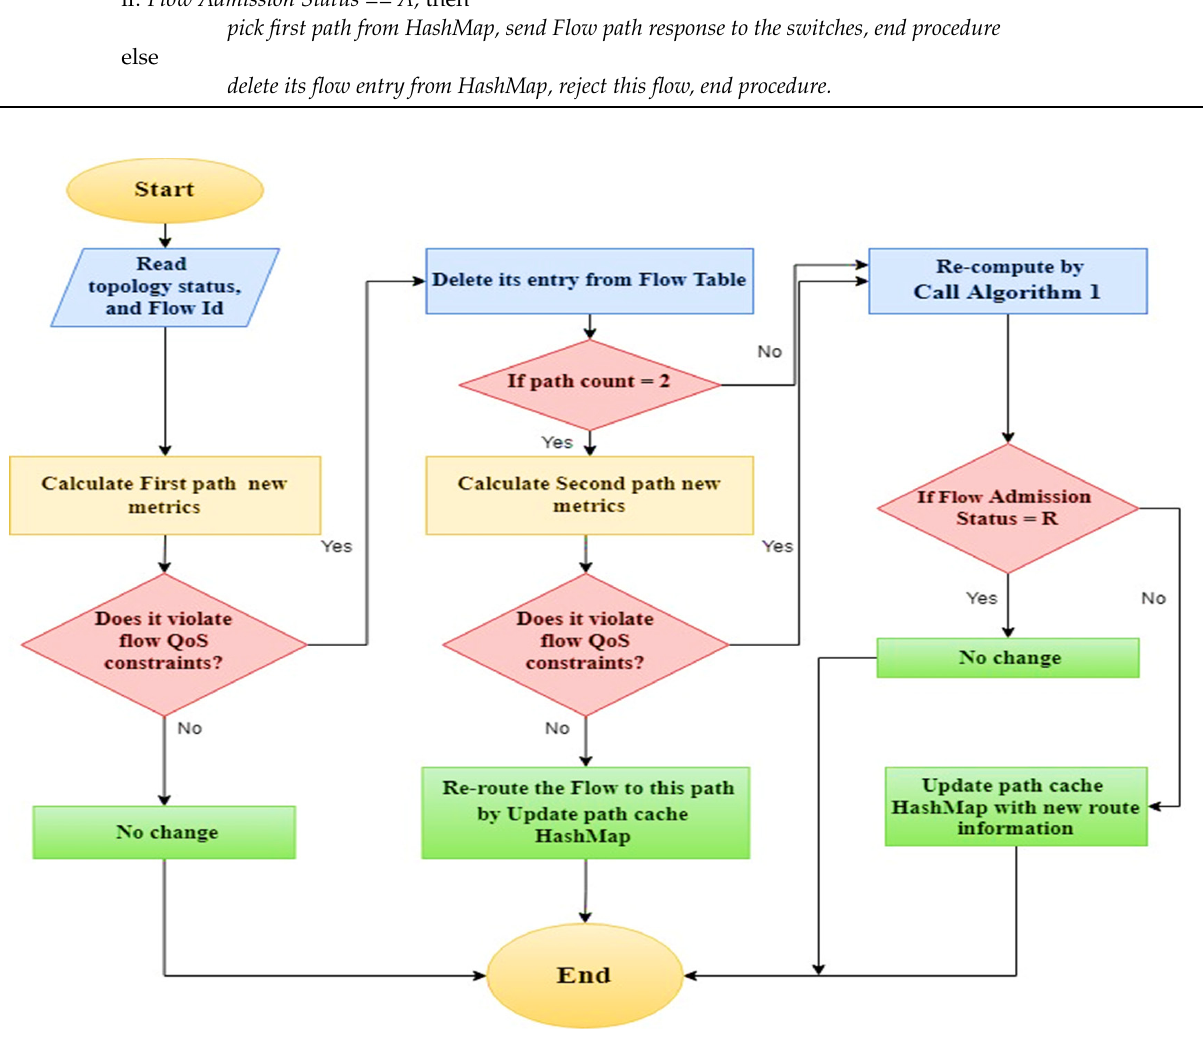
Figure 2. Dynamic re-routing algorithm (DR-RA) flowchart.